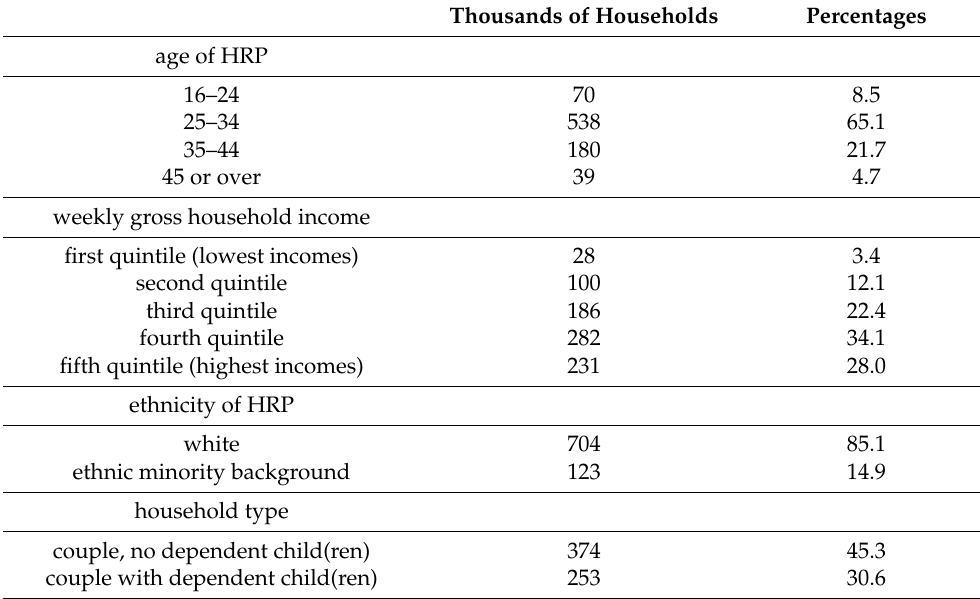
Table A6. Demographic and economic characteristics, recent first-time buyers,